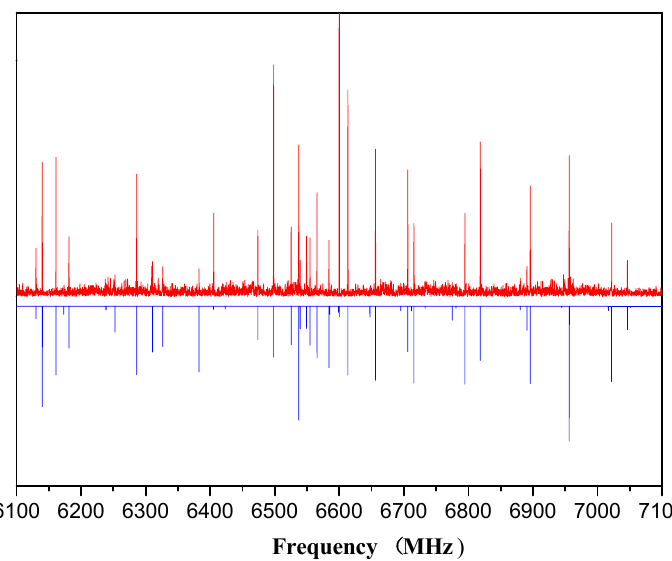
Figure 3. Experimental spectrum of 10,000 acquisition cycles of benzophenone with 1 GHz bandwidth (top, red, LO = 6.6 GHz), compared to a simulation at 10 K generated using the constants from [8] (bottom, blue).